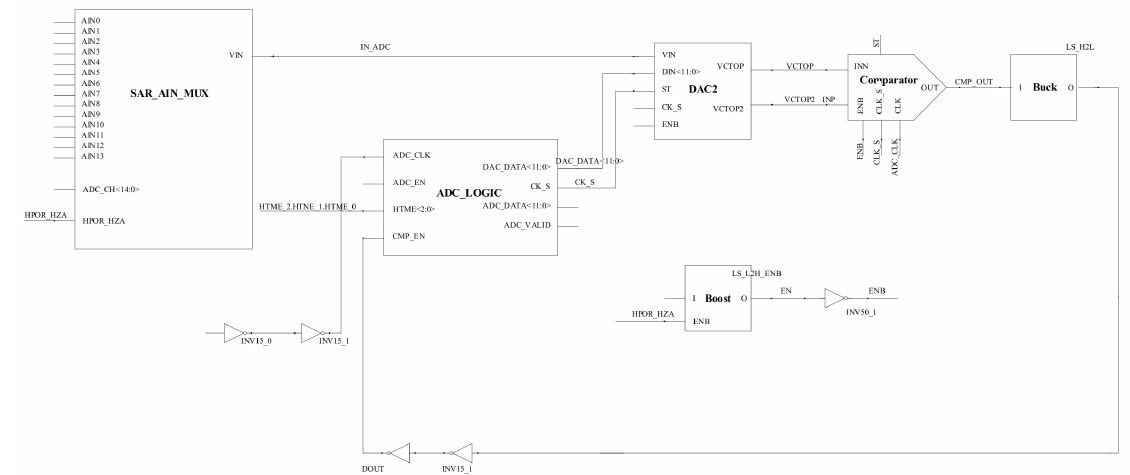
Figure 5. Circuit diagram of 12-bit SAR